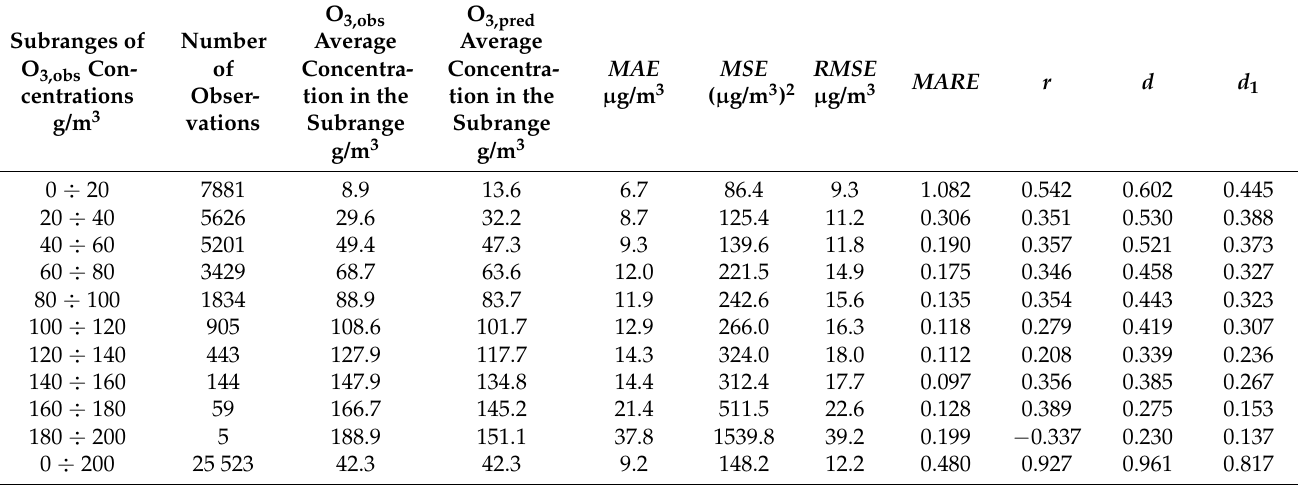
Table 2. Values of approximation errors calculated for different subranges and the entire range of O 3,obs concentrations (hourly data, Zabrze 2011–2016); O 3,obs means real O 3 concentration, and O 3,pred means predicted O 3